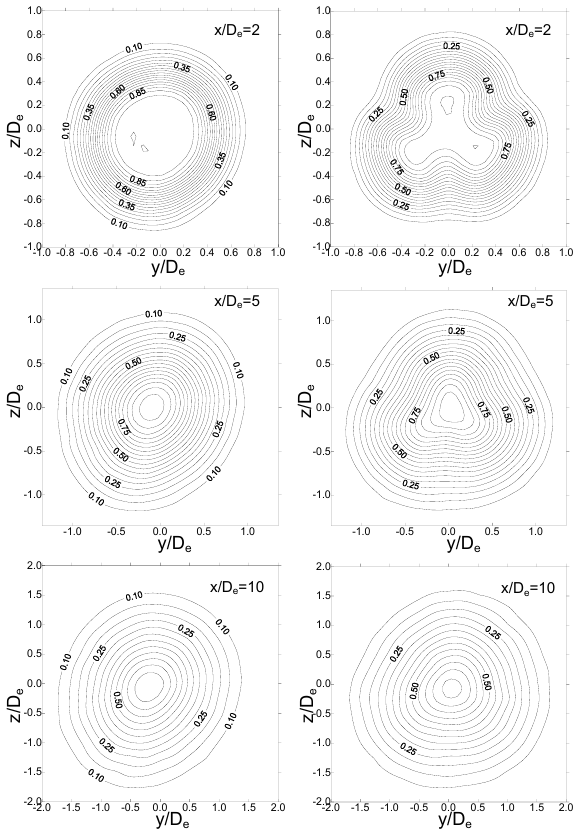
Fig. 6. Axial velocity (U/U 0 ) contours